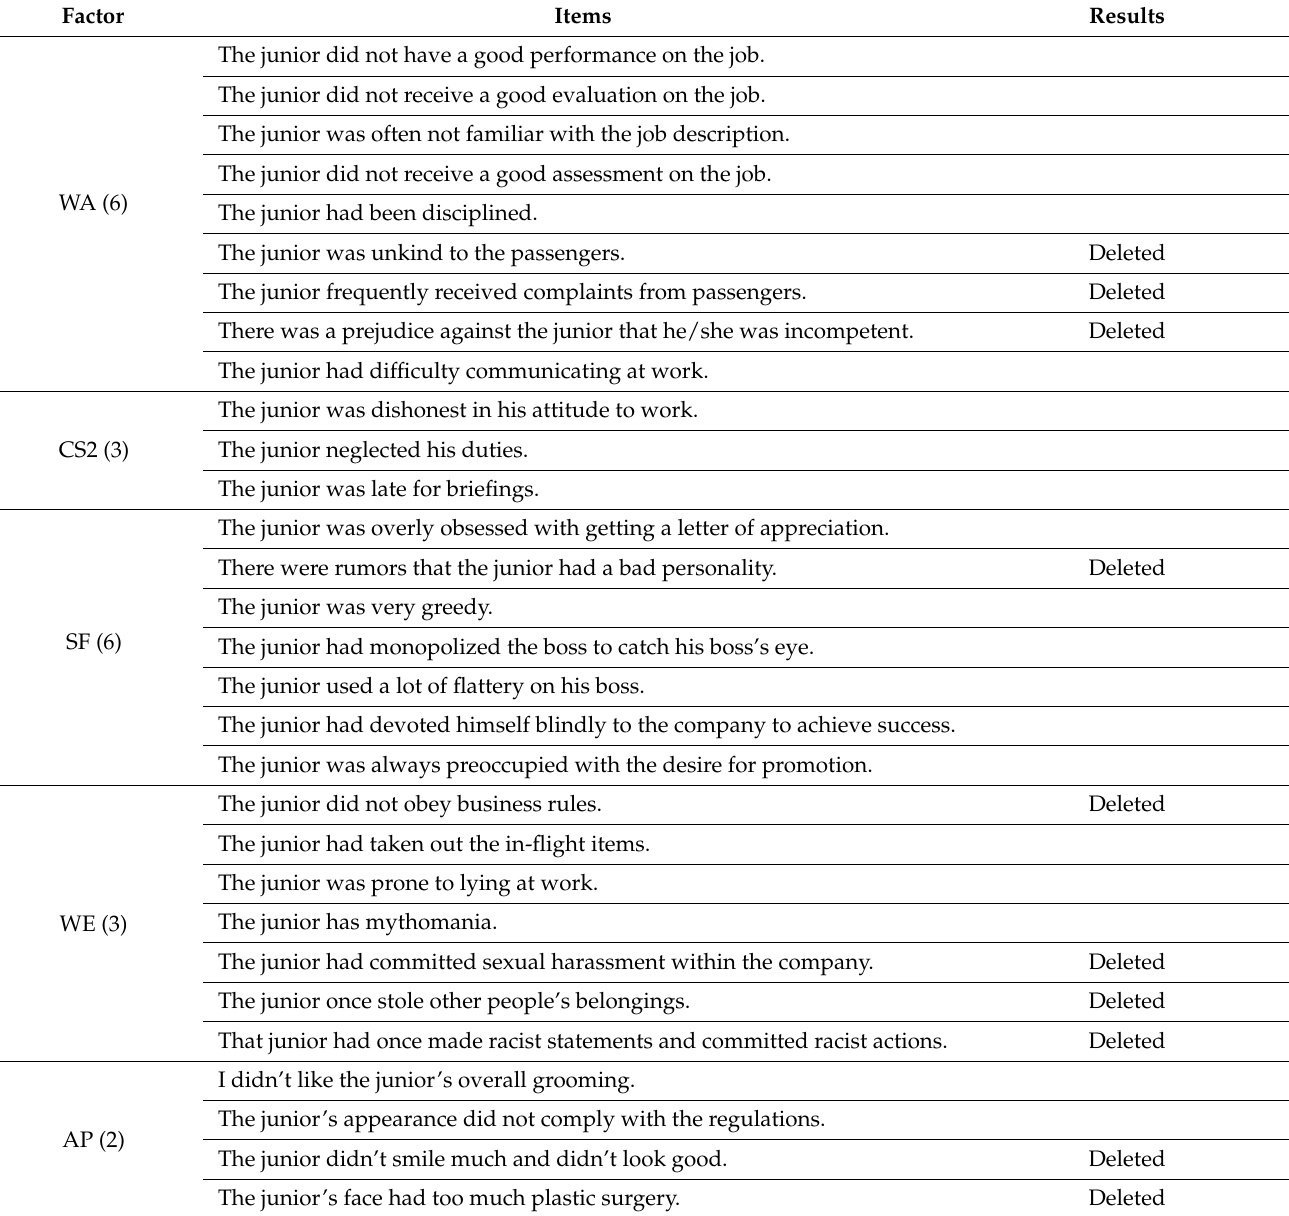
Table 7. Results of the stigma scale development for airline cabin